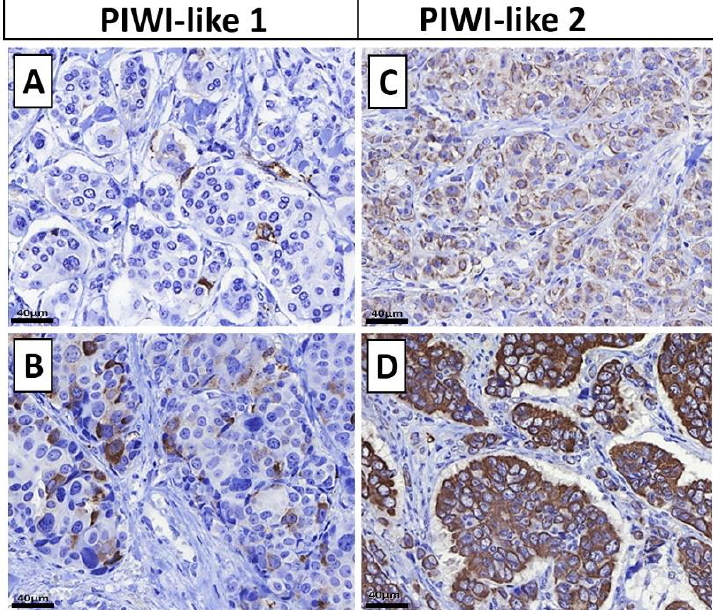
Figure 3. ( A , B ) Immunohistochemical staining of PIWI-like 1 and ( C , D ) PIWI-like 2 in breast cancer (IHC, 400 × ). In general, most tumors showed no or only slight PIWI-like 1 expression; few tumors showed a higher PIWI-like 1 staining: PIWI-like 1 IHC expression is almost negative in ( A ), whereas it is easily recognizable in ( B ). Note the cytoplasmic staining. Although most breast cancer cases showed PIWI-like 2 expression, there were di ff erences in intensity and percentage of positively-stained tumor cells identifiable: PIWI-like 2 membranous and cytoplasmic staining is weak in ( C ), but strong in ( D